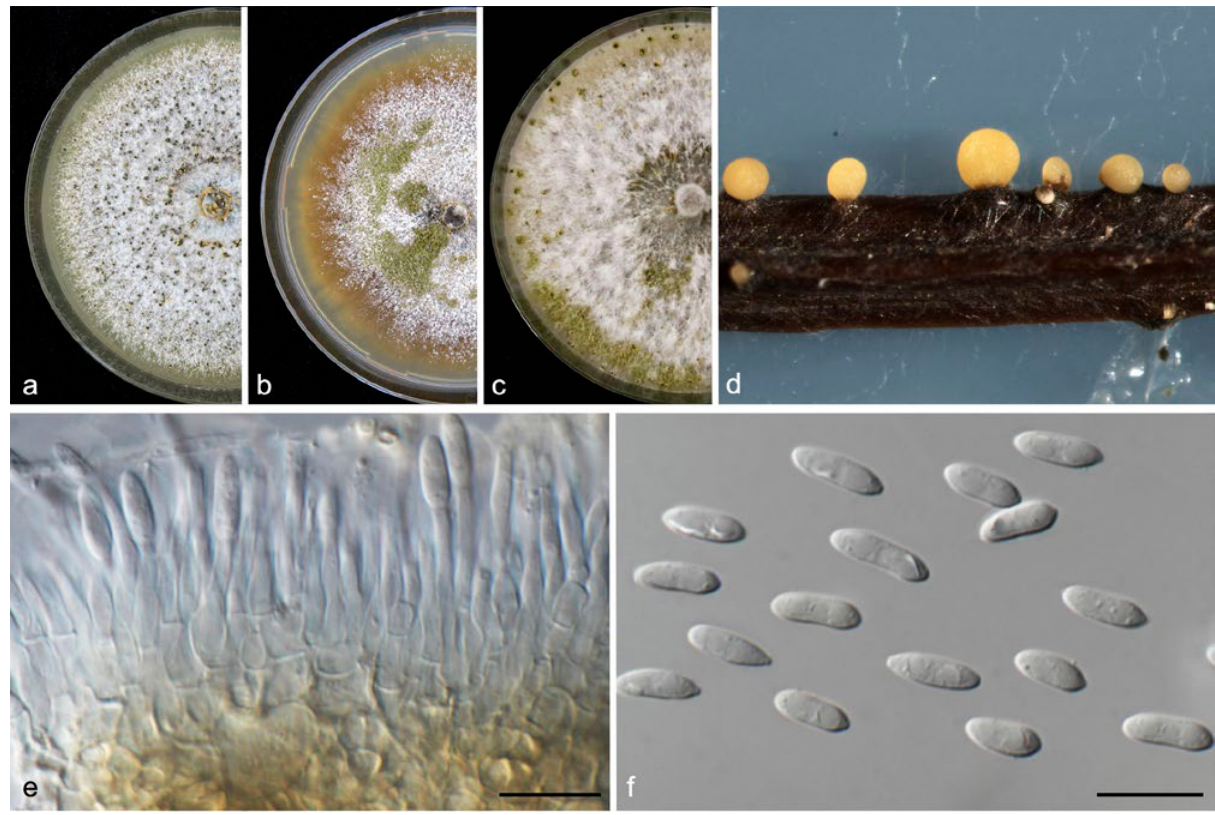
Figure 3. Diaporthe citri (CBS 144227). (a–c) Colonies after 7 d at 21°C on MEA, OA and PDA. (d) Conidiomata sporulating on PNA. (e) Conidiogenous cells. (f) Alpha conidia. Scale bars = 10 μ